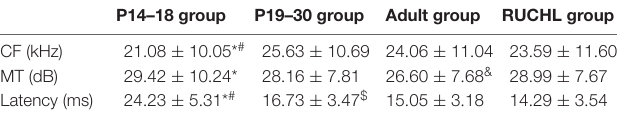
TABLE 1 | The basic response properties of primary auditory cortex (AI) neurons in the four groups of